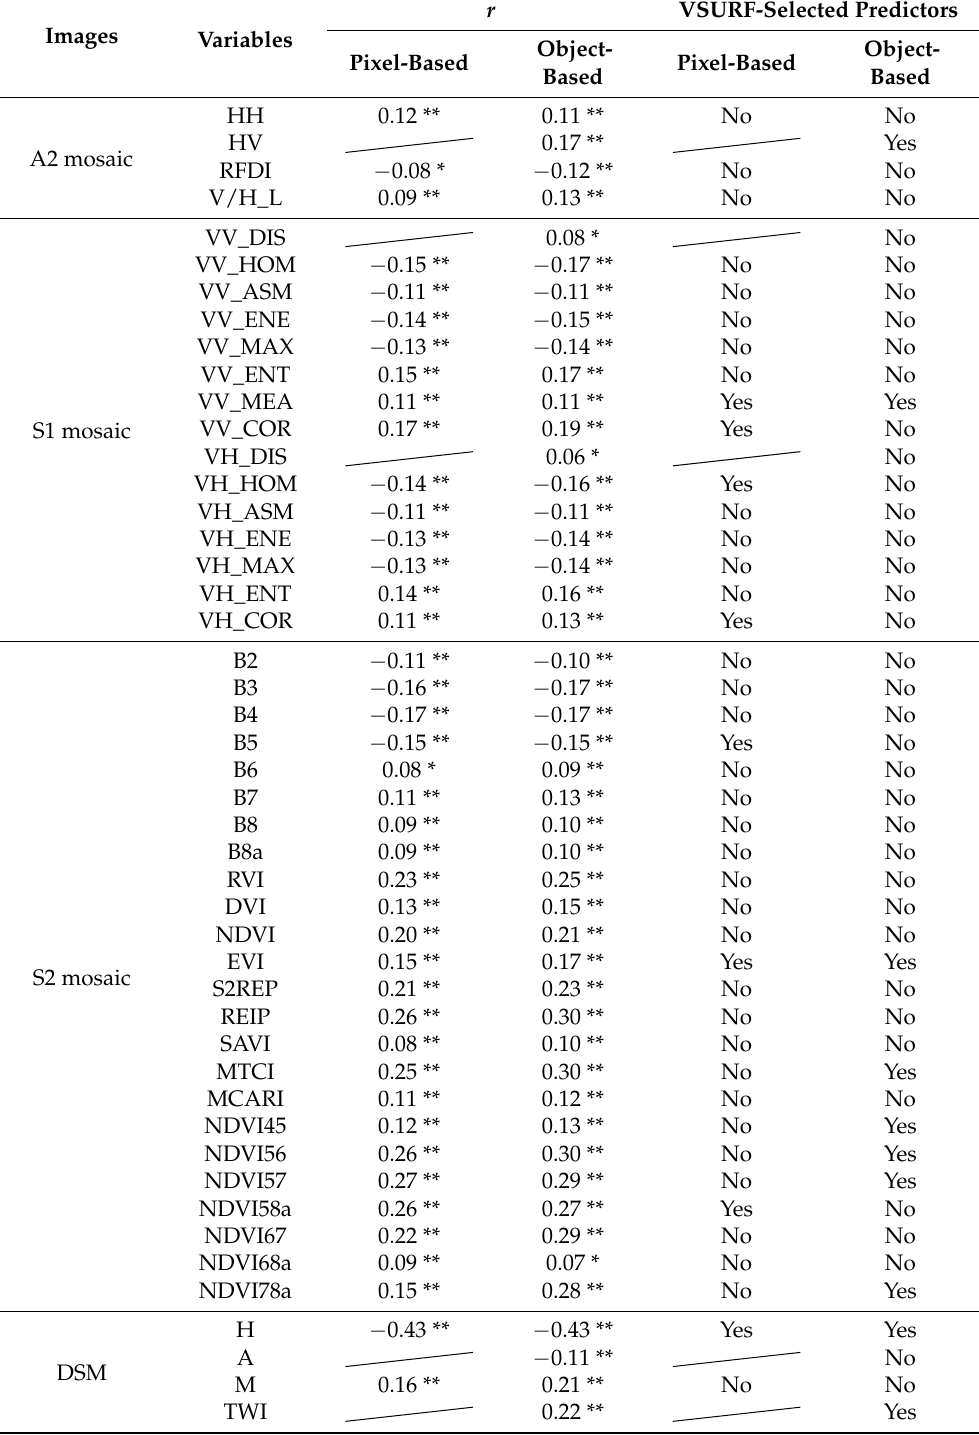
Table 6. The filtering result of predictor variables from remote sensing indices which were signifi- cantly related to measured AGB with a mark * as the p -value of the t -test being below 0.05 and ** as a p -value below